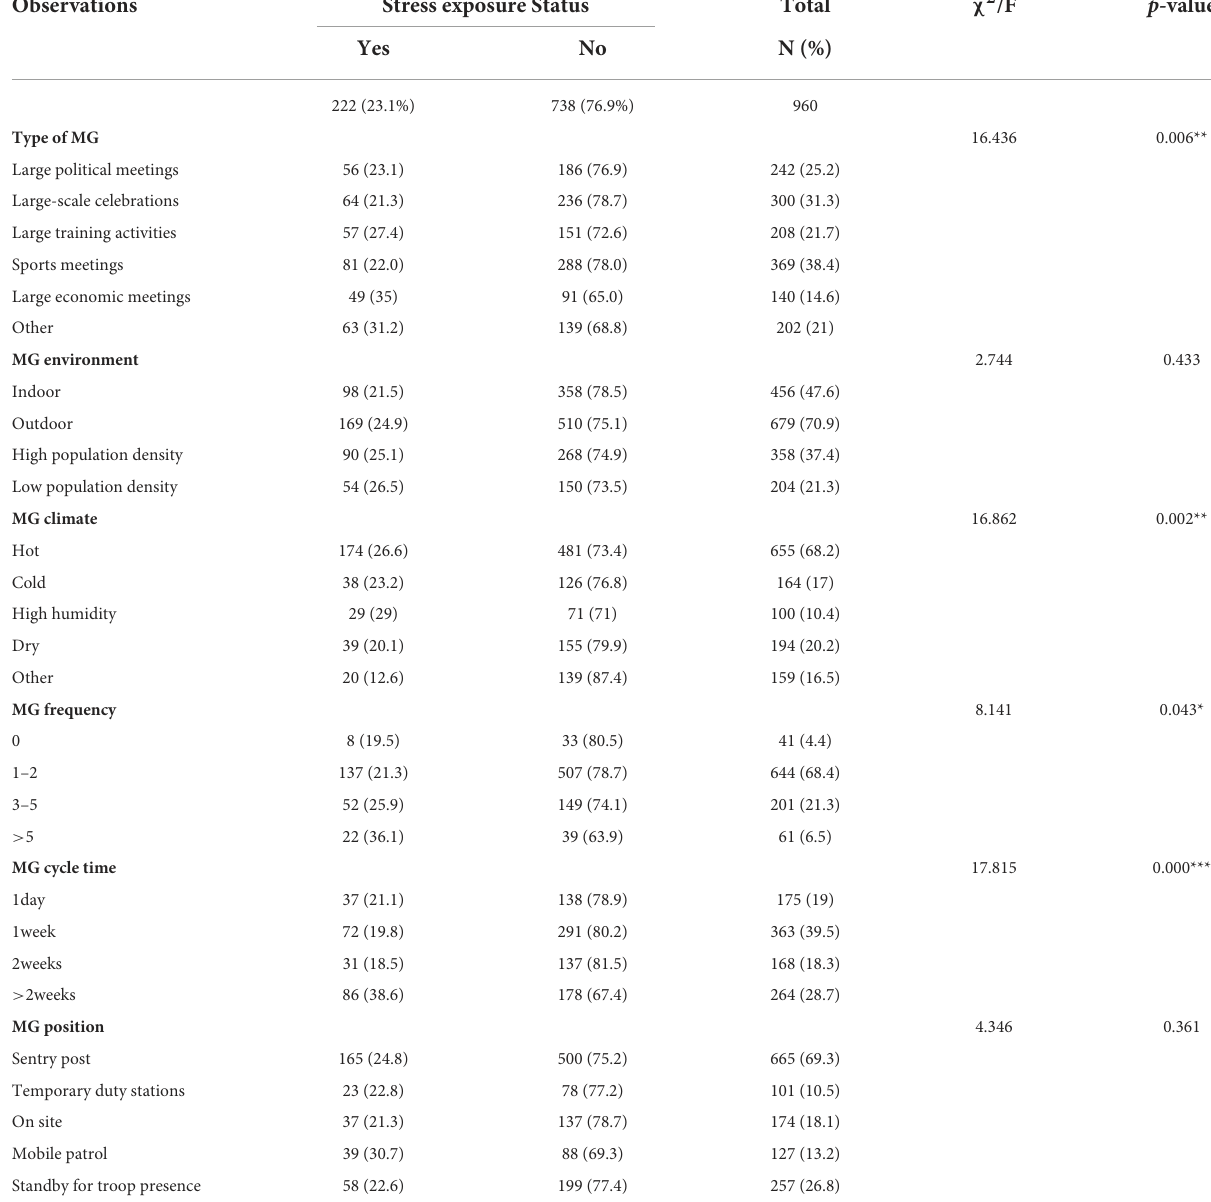
TABLE 2 MG deployment factors associated with PAP personnel’s stress exposure